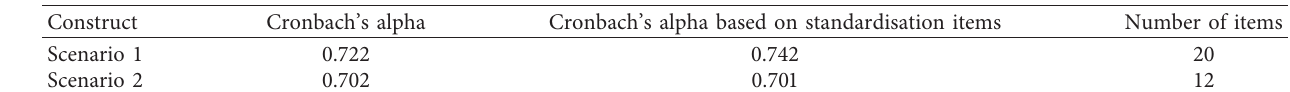
Figure 4: A flowchart showing the description of the algorithm. Table 2: Reliability